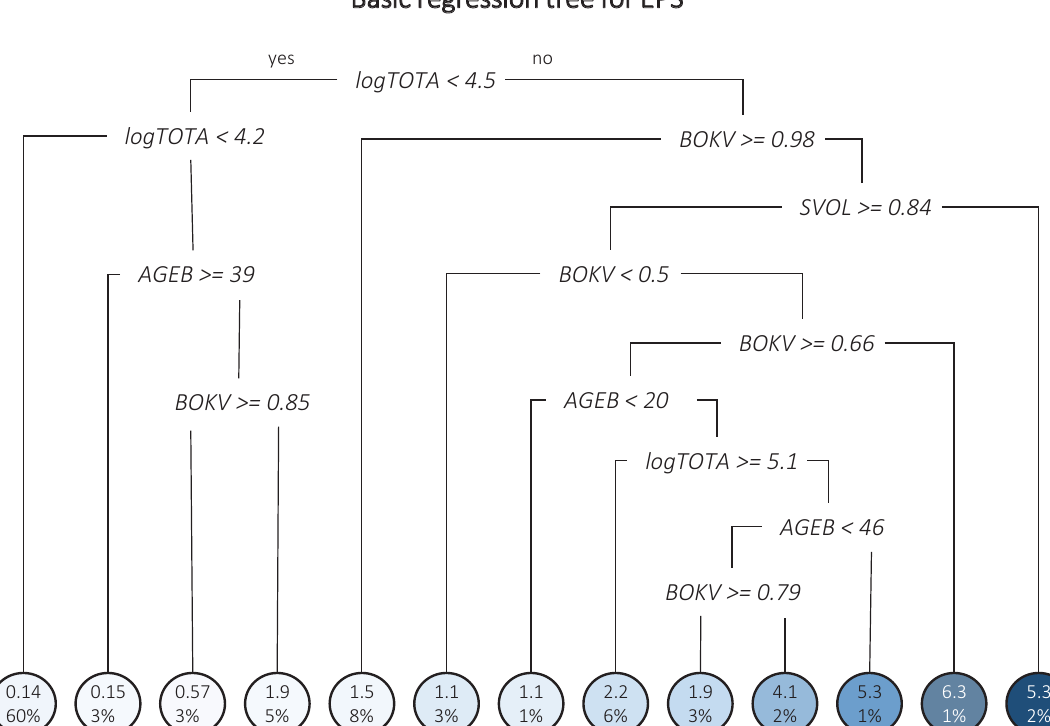
Basic regression tree for